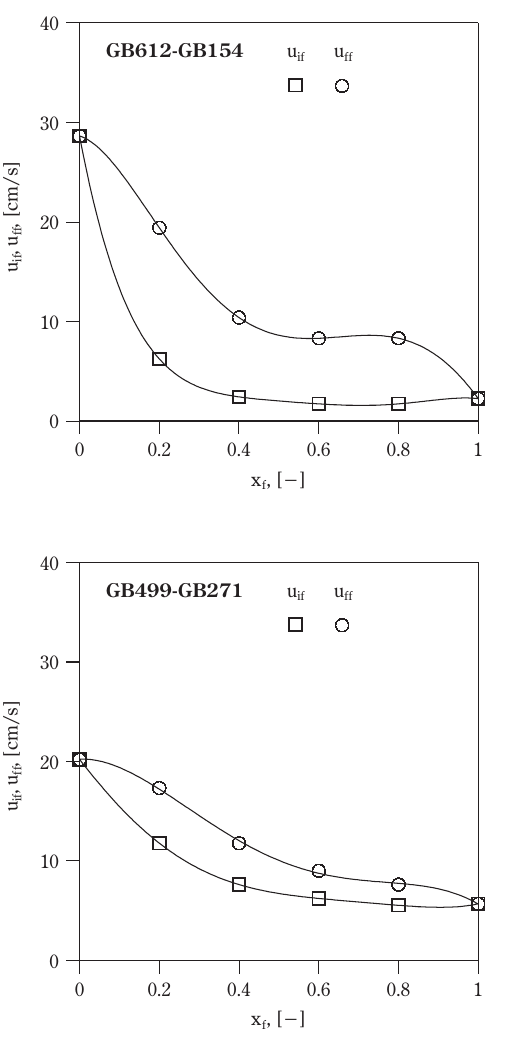
Fig. 10 Fluidization velocity range of size segregating mixtures. Segregated